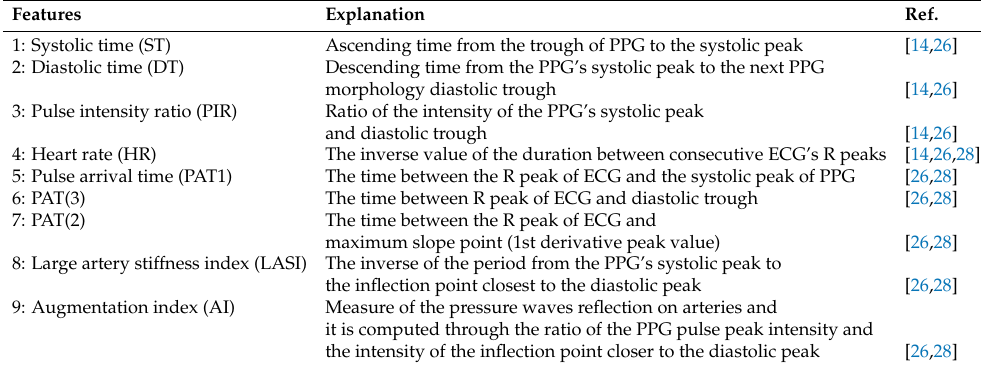
Figure 3. Feature extraction from the 1st and 2nd derivative of PPG waveforms, where ( a ) is a PPG signal example, ( b ) denotes the 1st derivative of the PPG wave signal, and ( c ) denotes the 2nd derivative of the PPG wave signal. Table 2. Summary of the features, part